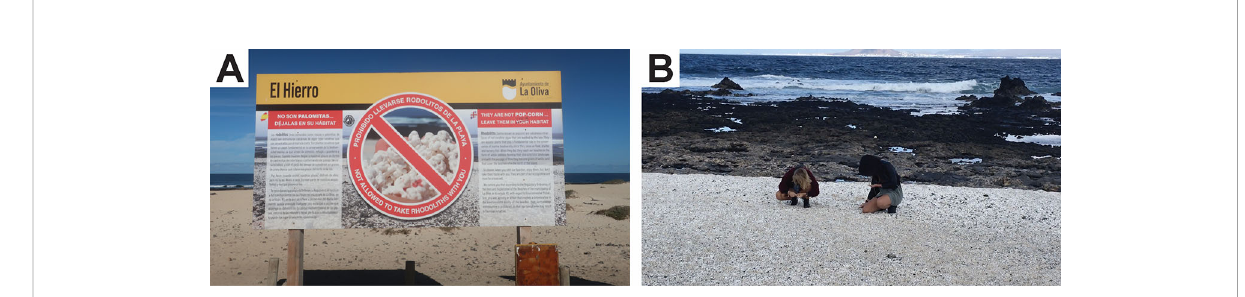
FIGURE 11 (A) Example of a prohibition sign for rhodolith picking at L4 - Playa El Hierro. (B) Rhodolith plundering at L2 – Caleta del Bajo de Mejillones. Photo courtesy of Fe ́ lix de la